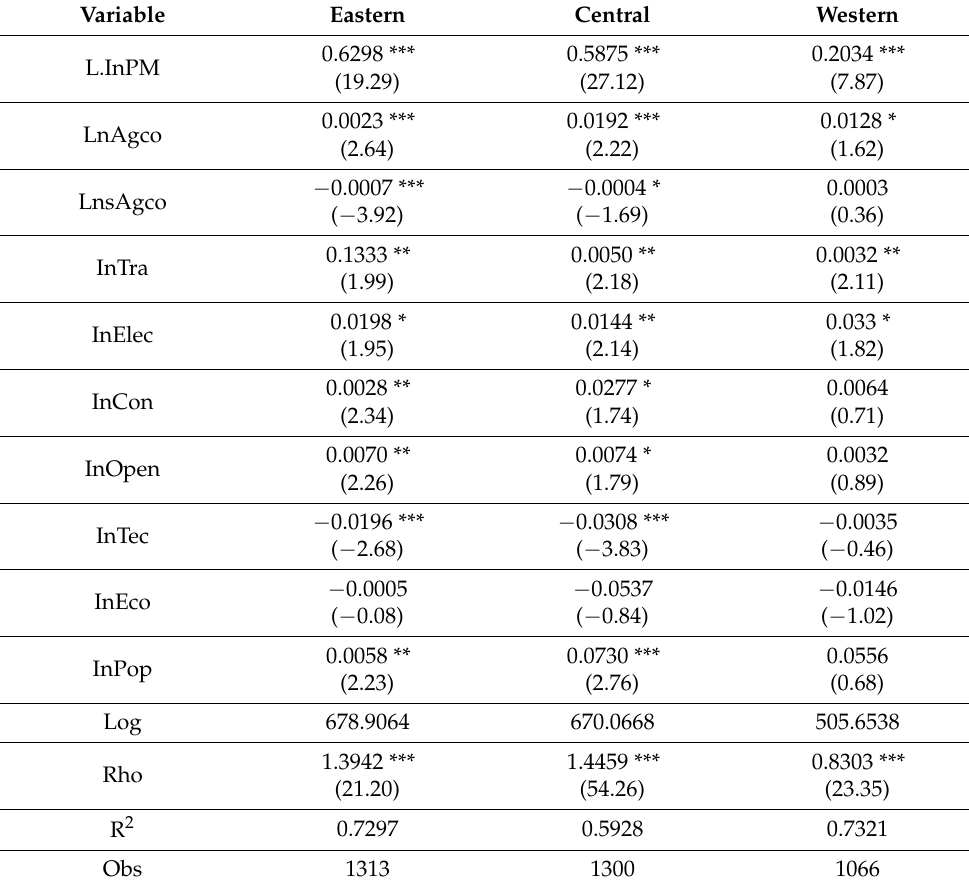
Table 6. Regional sample